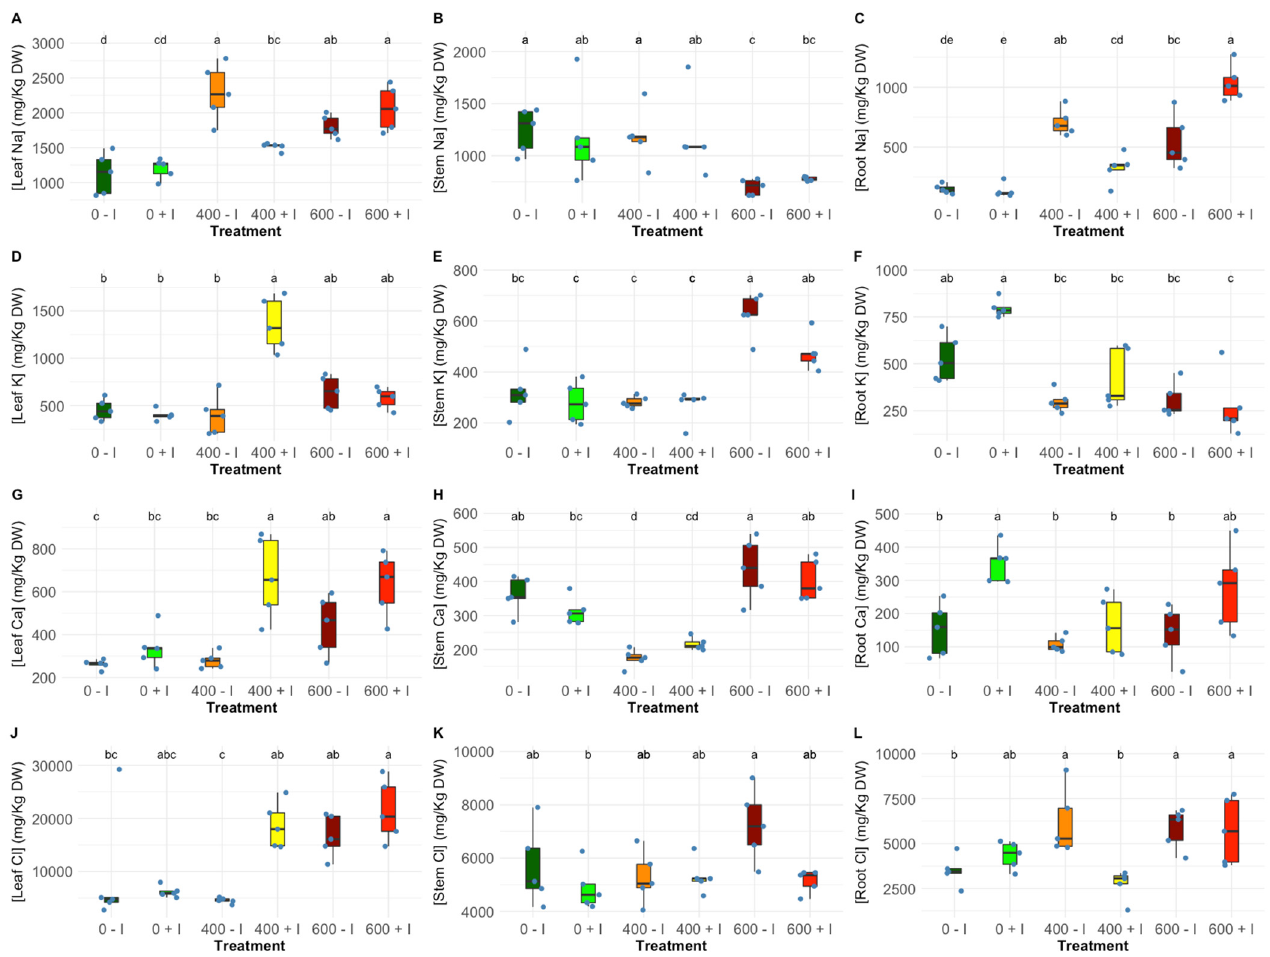
Figure 3. ( A – C ) Sodium (Na), ( D – F ) potassium (K), ( G – I ) calcium (Ca) and ( J – L ) chloride (Cl) concentration (mg/Kg) in non ‐ inoculated and inoculated Halimione portulacoides (N = 5) leaf, stem and root tissues (N = 5), along with the tested NaCl concentrations. Letters indicate significant differences between treatments at p < 0.05.